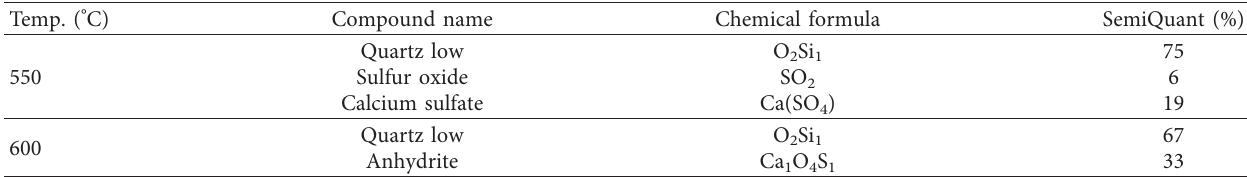
Figure 9: Comparison of 100x and 1,000x magnification of BD-4B at (a) 550 ° C and (b) 600 ° C. Table 13: XRD analysis of BD-4B